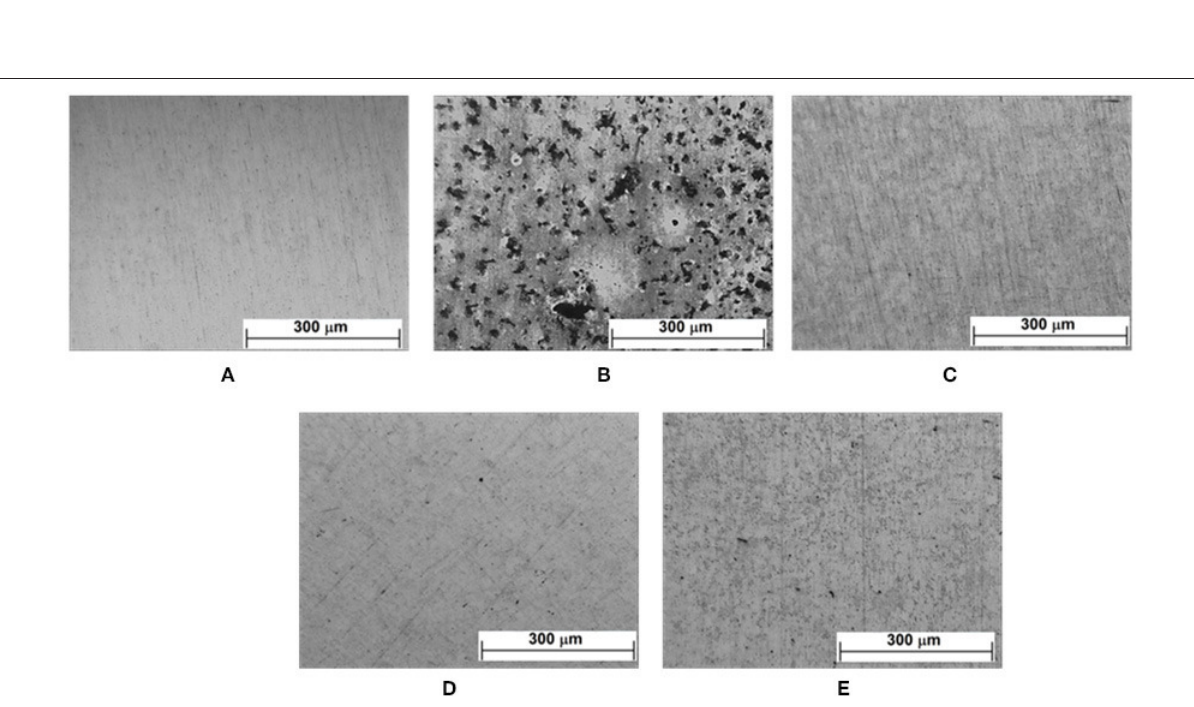
Frontiers in Chemistry | www.frontiersin.org